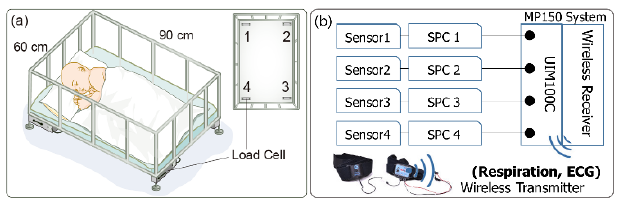
Figure 1. ( a ) Design of physiological signal monitoring bed for infants; ( b ) Experimental setup of signal